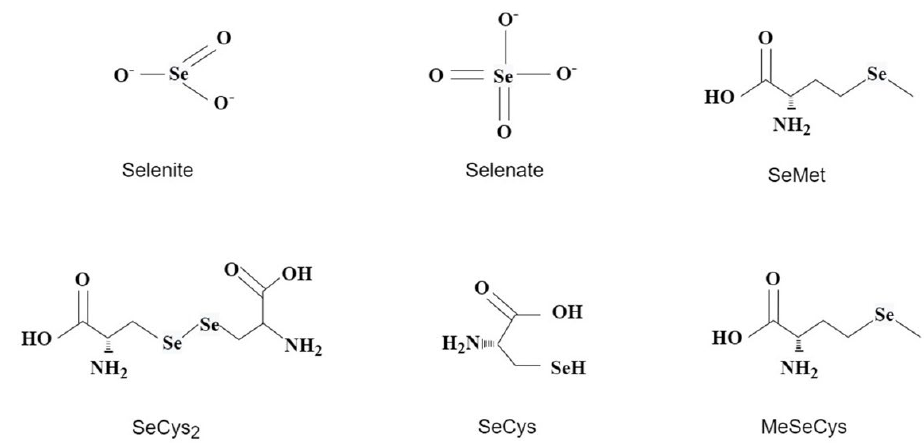
Figure 2. Main inorganic selenium and organic selenium species in tea